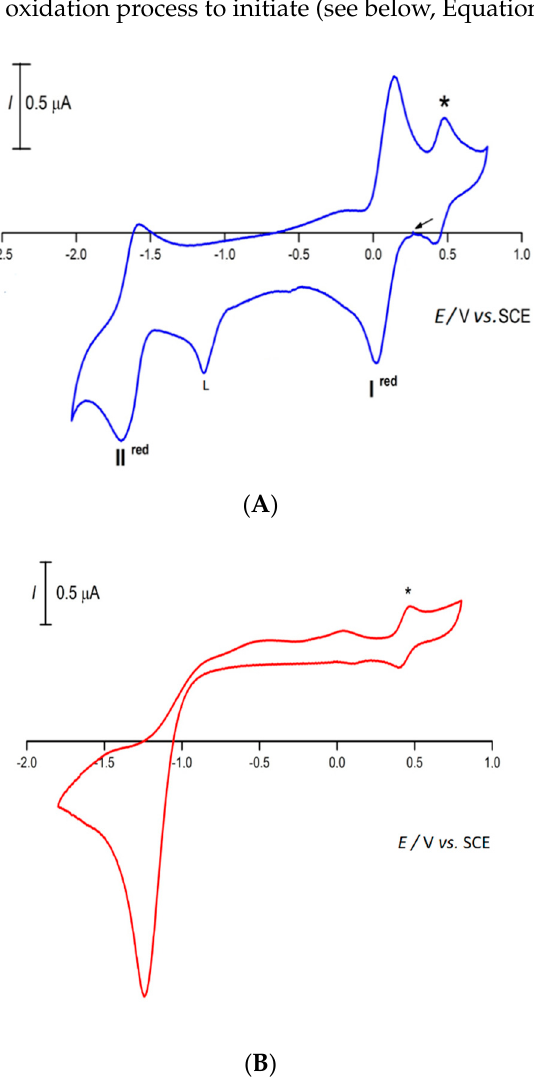
Figure 6. Cyclic voltammogram, initiated by the cathodic sweep, of ( A ) 4 or ( B ) HL in a 0.2 M [ n Bu 4 N][BF 4 ] / DMSO solution, at a Pt disc working electrode ( d = 0.5 mm), run at a scan rate of 100 mVs − 1 . * [Fe( η 5 -C 5 H 5 ) 2 ] 0 /+